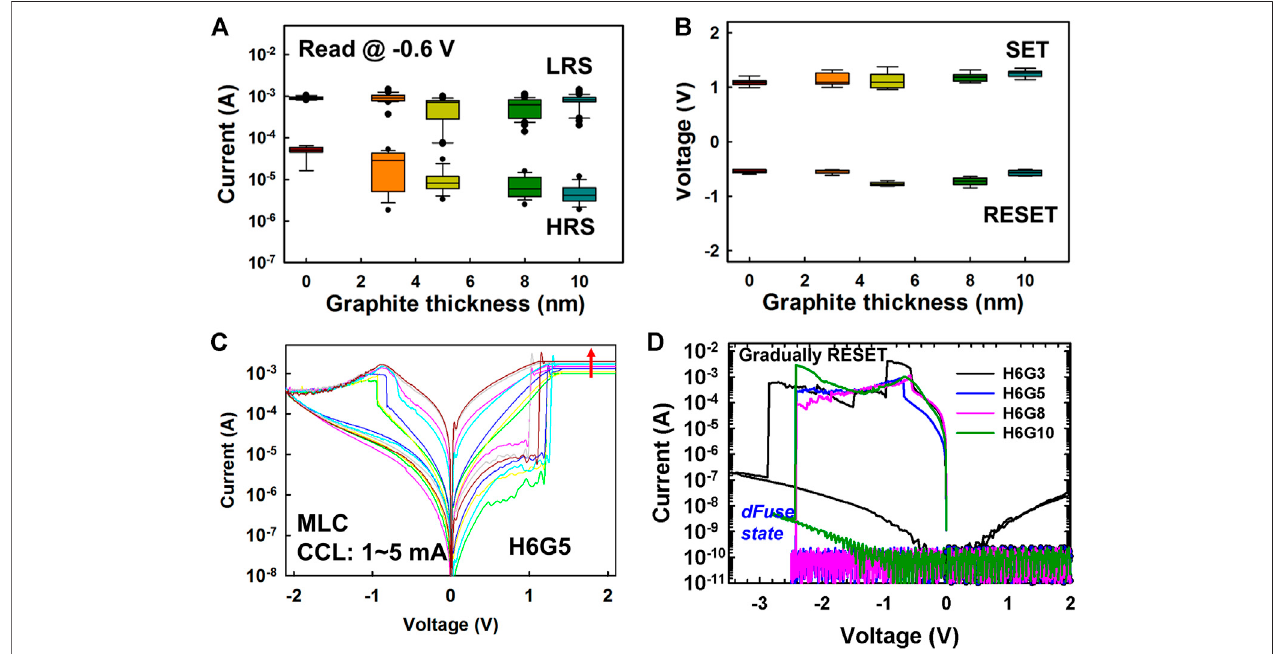
FIGURE 3 | (A) Low resistance state (LRS) and high resistance state (HRS) for various graphite thickness, (B) SET and RESET voltage for various graphite thickness, (C) I-V characteristics with SET CCL modulations on H6G5, (D) dielectric fuse state for varied graphite thickness.